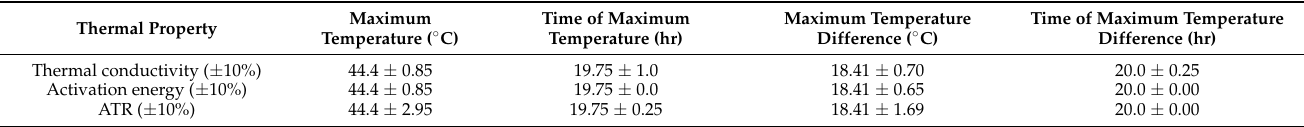
Figure 18. Temperature analysis sensitivity due to measured thermal properties: ( a ) Thermal conductivity (Temperature) ( b ) Thermal conductivity (Temperature difference), ( c ) Activation energy (Temperature), ( d ) Activation energy (Temperature difference), ( e ) ATR (Temperature) and ( f ) ATR (Temperature difference). Table 7. Thermal analysis